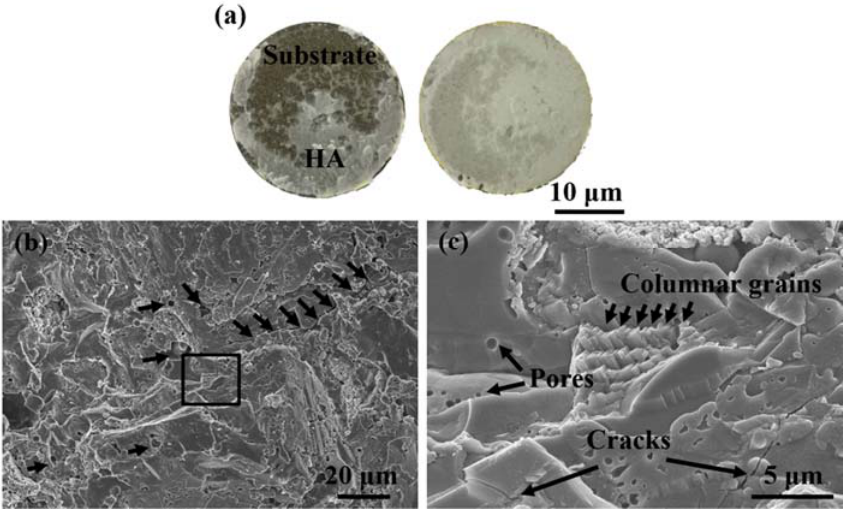
Figure 3. ( a ) Photographs after bonding strength test; ( b ) SEM image of fracture surface; ( c ) SEM image of fracture surface at high magnification.